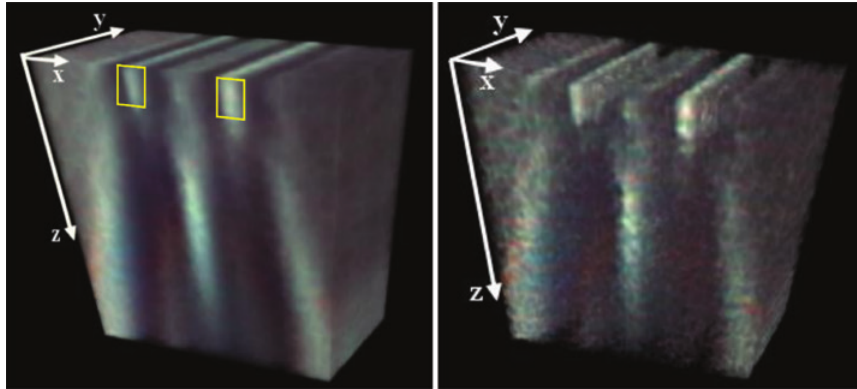
Figure 6: White-light 3D intensity distributions diffracted by a pair of parallel polymer lines separated by 2 μ m. Left: raw z-stack images. Right: deconvoluted z-stack images. Yellow rectangles represent line profiles (W = 0.4 μ m and H = 0.9 μ